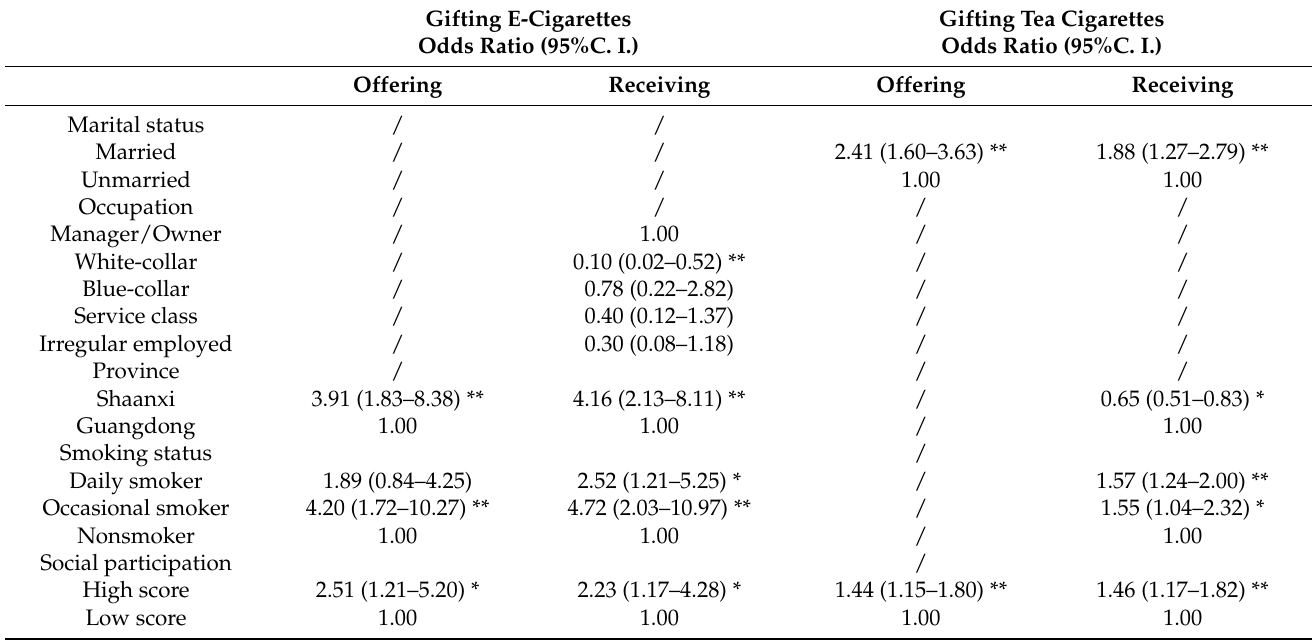
Table 2. Logistic regression results of socio-demographic factors associated with gifting e-cigarettes and tea cigarettes. Gifting E-Cigarettes Odds Ratio (95%C. I.)